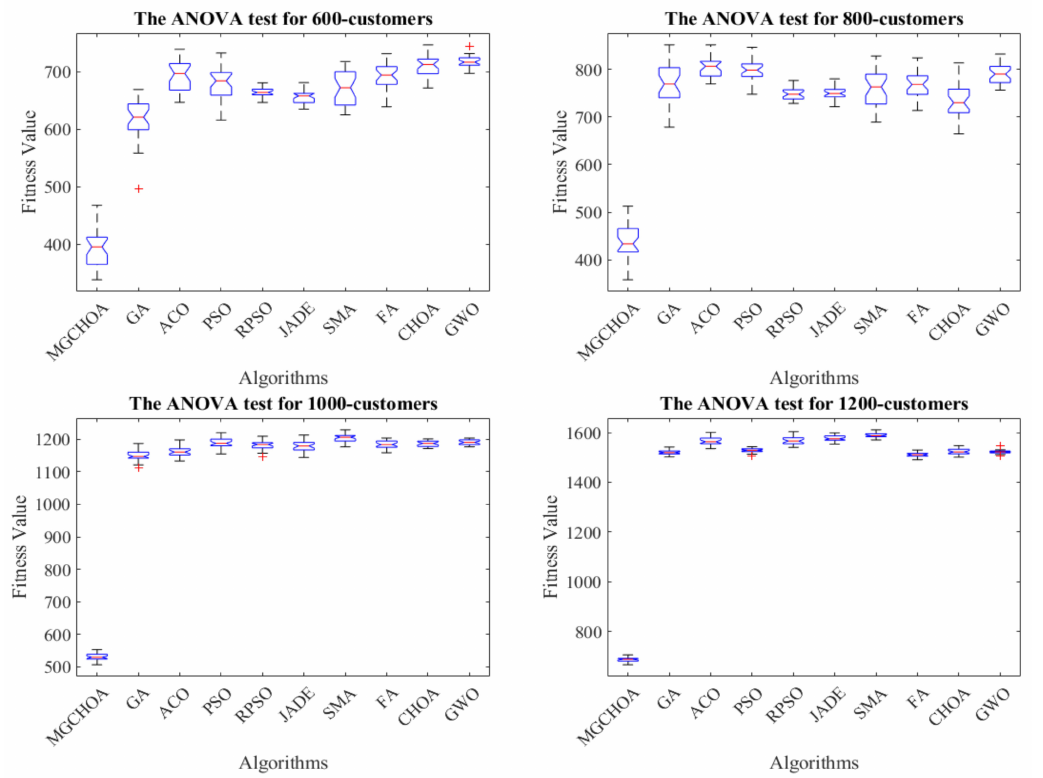
Figure 15. The ANOVA tests of the result after 30 runs, the blue box denotes the data distribution, the red line represents the median value, and the red symbol denotes the abnormal value.